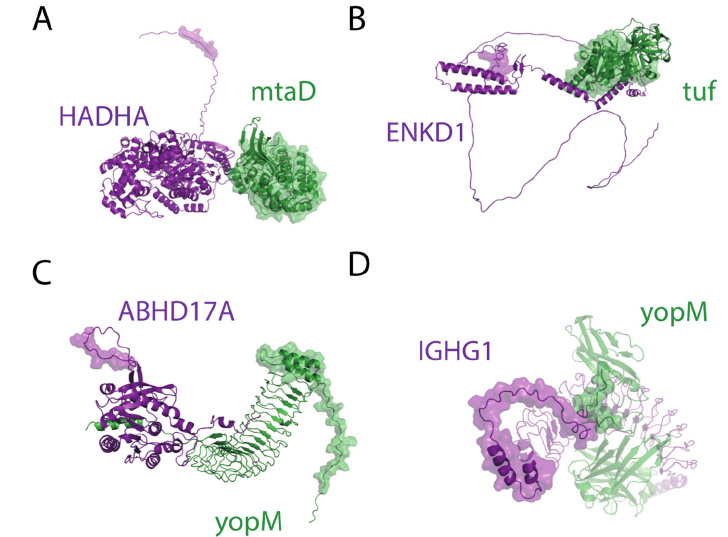
Figure 8. Domain–motif interactions predicted by Alphafold Multimer. ( A ) HADHA-mtaD; ( B ) ENKD1-tuf; ( C ) ABHD17A-yopM; ( D ) IGHG1-yopM. ( B ) ENKD1-tuf; ( C ) ABHD17A-yopM; ( D )